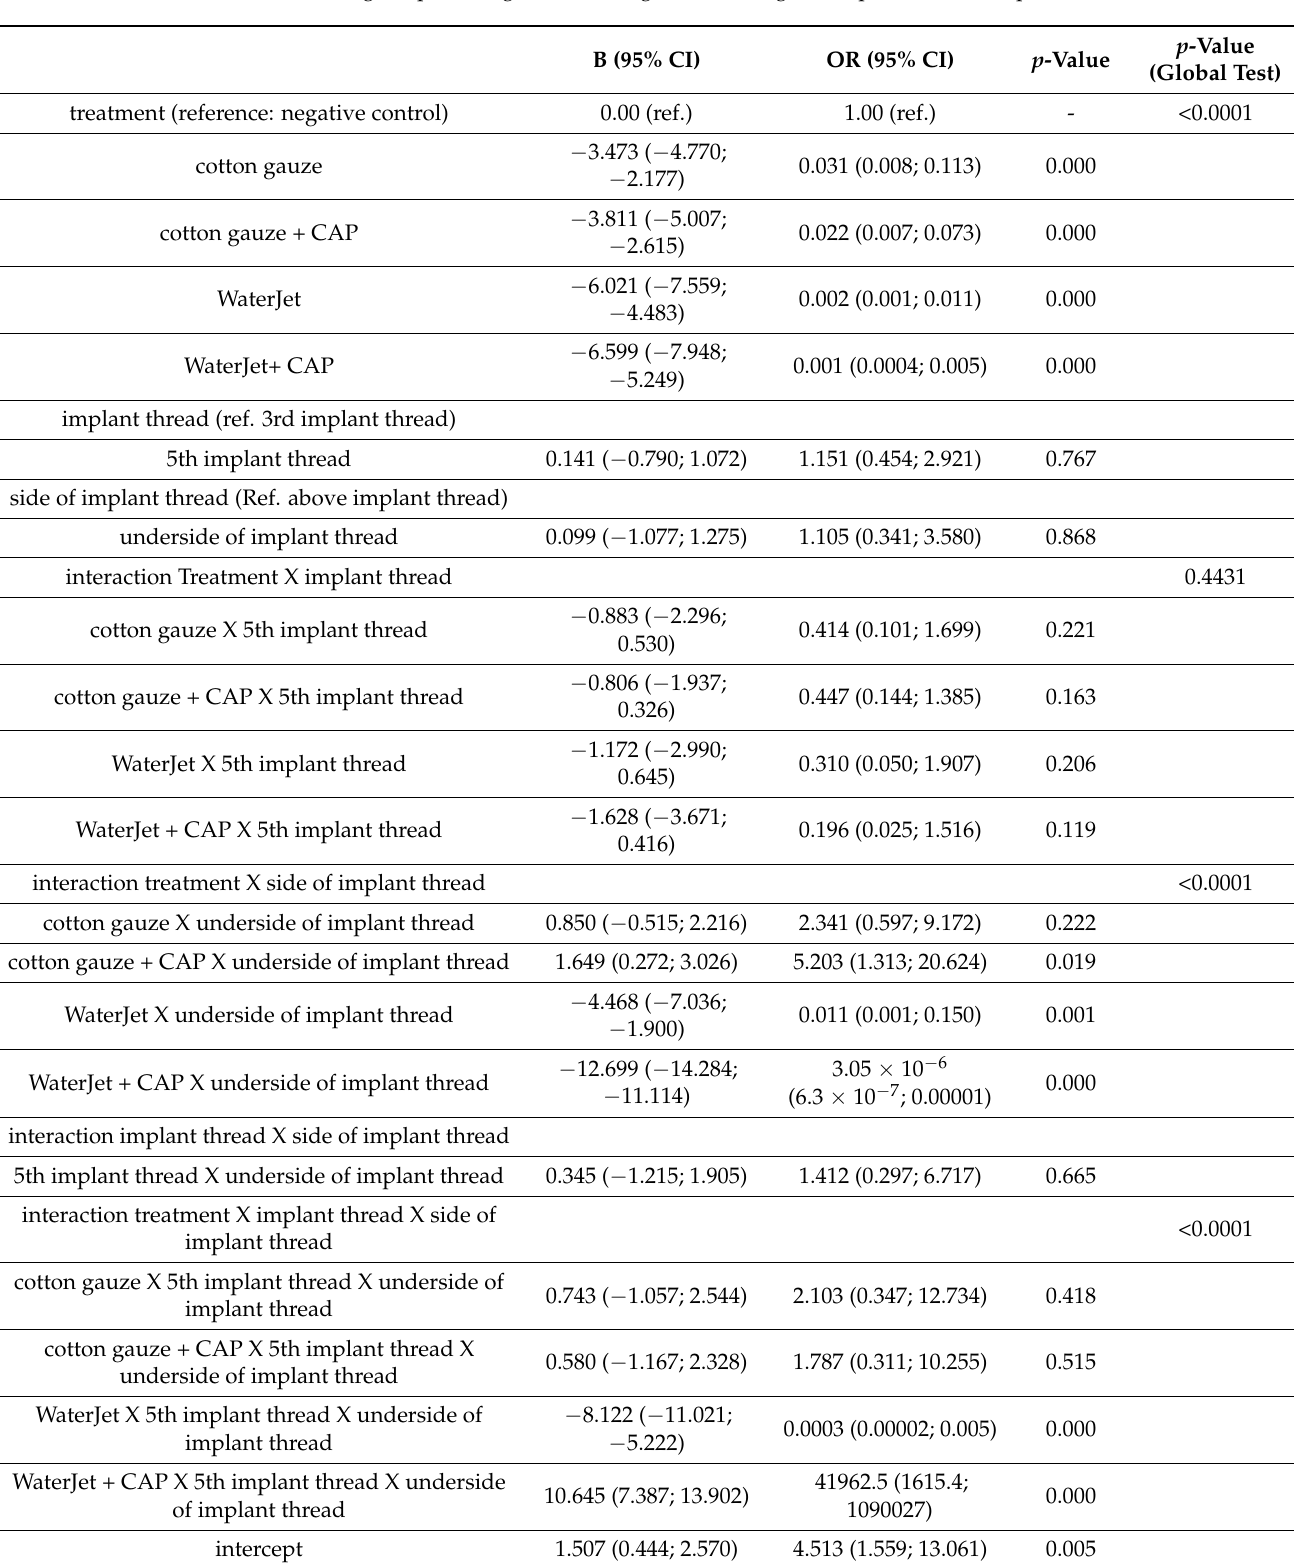
Table A5. Statistics of SEM analysis. Effect estimates from binomial regression models with logit link using the percentage of ‘microorganisms or organic deposits’ as the dependent